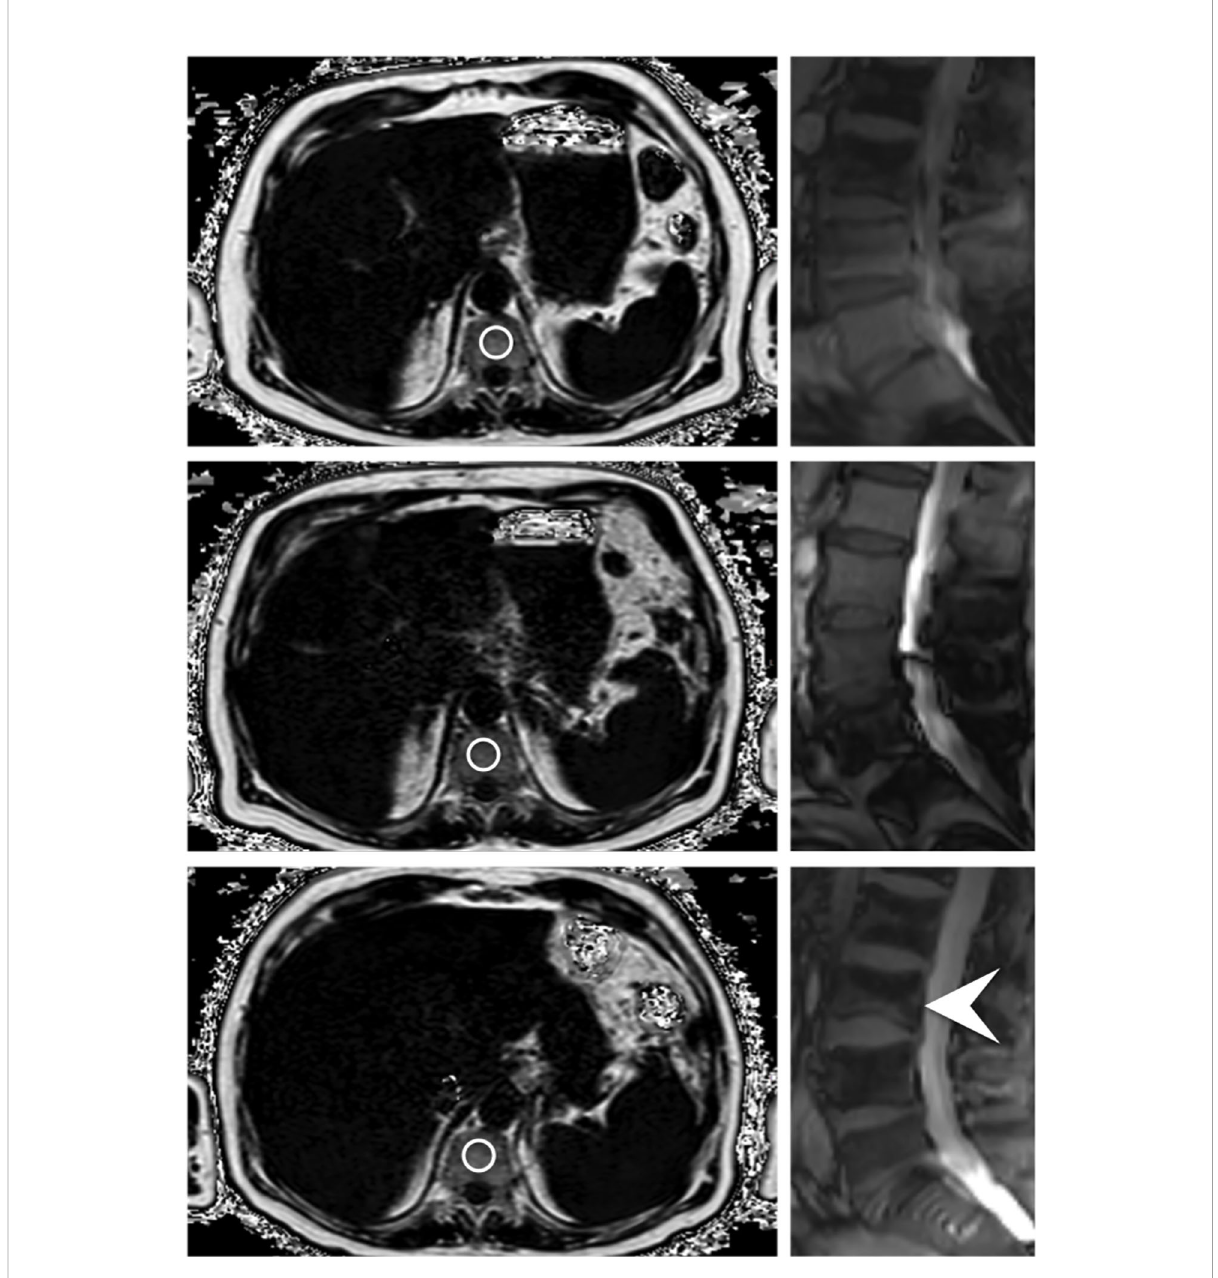
FIGURE 2 Axially acquired gradient echo sequences for chemical shift encoding-based water-fat separation of a 78 year old male patient at baseline, fi rst follow- up and at the time offracture occurrence; the images on the right originate from the corresponding survey in sagittal orientation, which reveal an incidental VCF of the base plate of L3 (indicated by the white arrowhead). The circles centrally placed in the vertebrae represent ROIs used for the PDFF